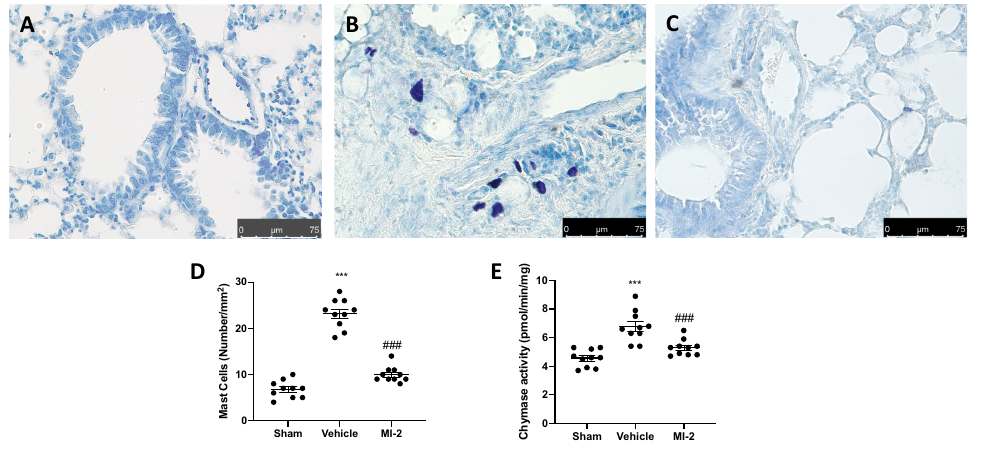
Figure 2. E ff ect of MI-2 on mast cells analysis: sham ( A ), vehicle ( B ), MI-2 ( C ), mast cells count ( D ); chymase activity ( E ). For each analysis, n = 10 animals from each group were employed.